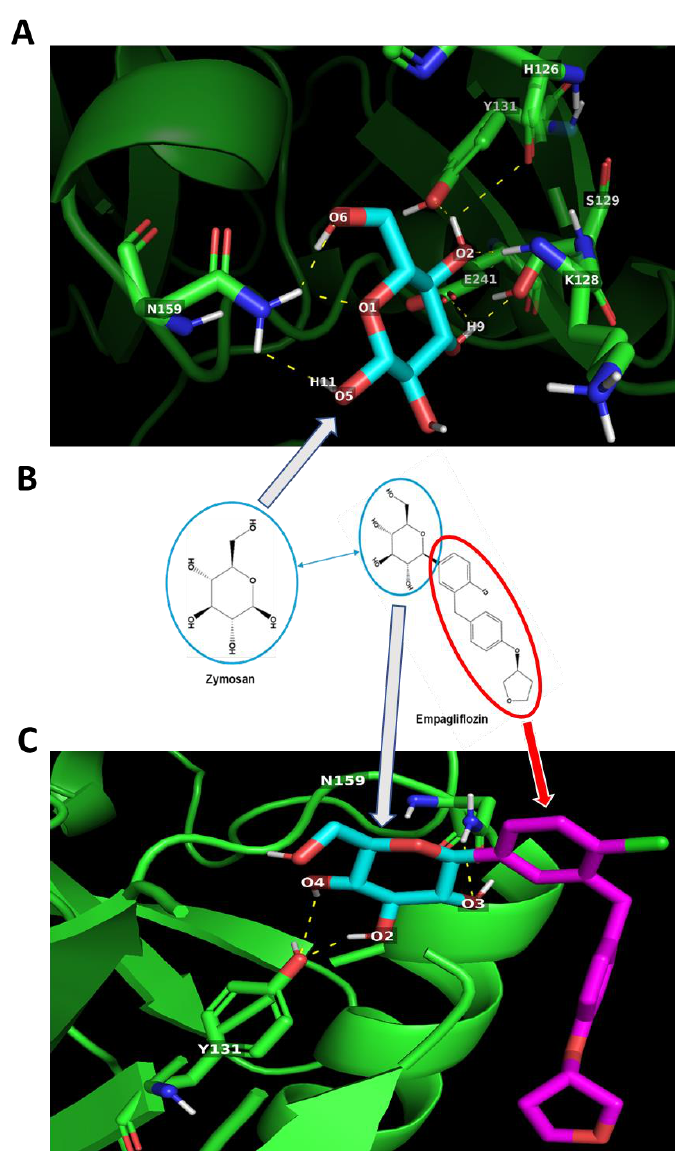
Figure 5. Potential Zymosan and empagliflozin interactions with Dectin-1. ( A ) Zymosan may interact via multiple hydrogen bonds (dotted yellow lines) with H126, K128, S129, Y131, N159, and E241 amino acid residues of Dectin-1. ( B ) Empagliflozin has a moiety identical to Zymosan. ( C ) The Zymosan-like moiety may enable Empagliflozin to interact with Y131 and N159 amino acid residues of Dectin-1 via H-bond